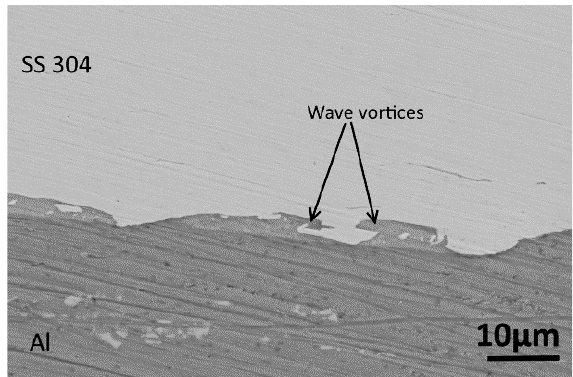
Figure 12. Mechanical interlocking at the interface.